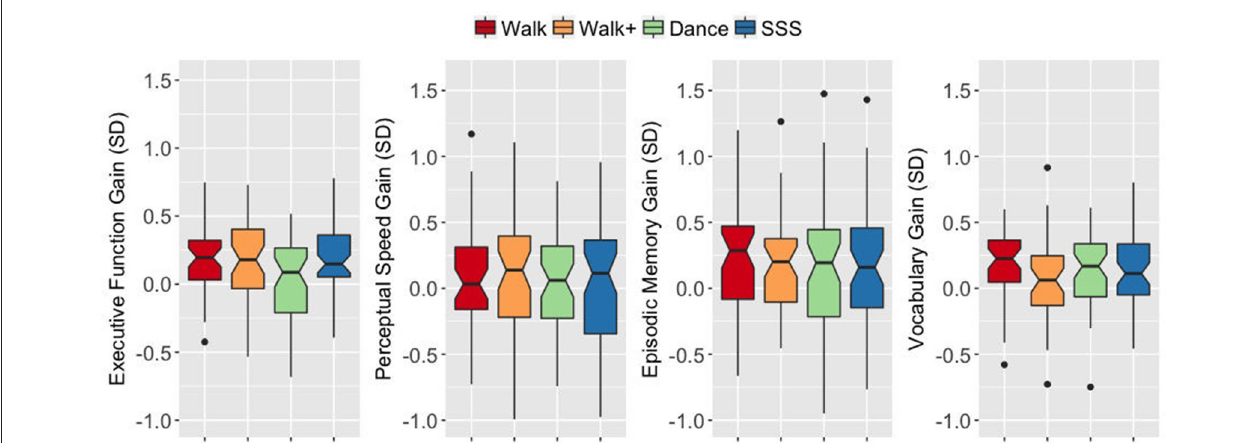
FIGURE 2 | Notched box plots show the distribution of composite gain scores before and after the intervention. The horizontal line marks the median. The notches extend to ± 1.58 IQR/sqrt(n). The upper and lower hinges correspond to the first and third quartiles. The whiskers extend from the hinge to ± 1.5*IQR of the hinge. IQR, inter-quartile